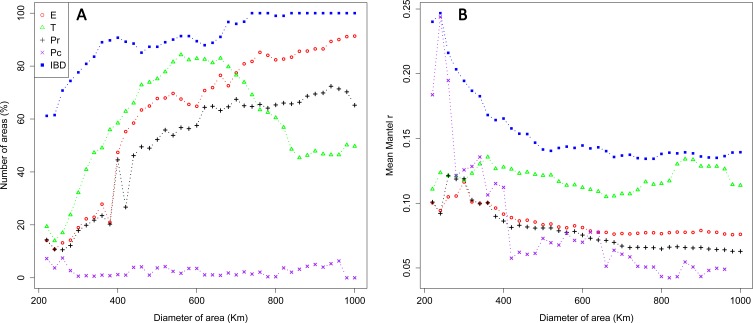
Percentage of areas with supported IBR hypotheses for Mantel tests (A) and mean partial Mantel r (B) of areas with support for the IBR hypotheses (p < 0.05) with increasing scales (whole dataset).E, Elevation; T, Mean minimum temperatures; Pr and Pc, pine densities as a resistant feature and as a corridor respectively; IBD, Isolation by distance.